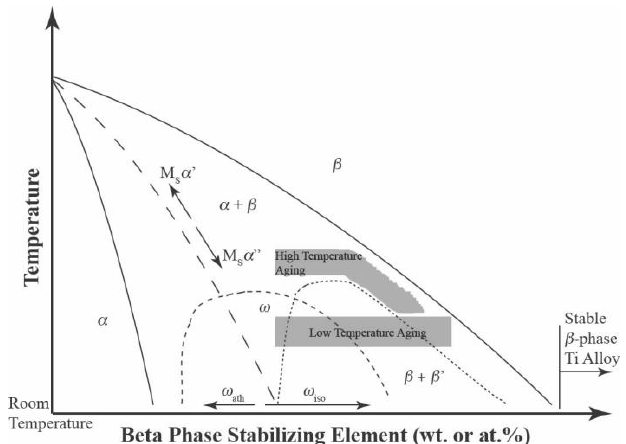
Figure 11. A schematic of a pseudo-binary isomorphous phase diagram from Figure 2 illustrating the differences between high and low isothermal aging temperatures for beta Ti alloys.